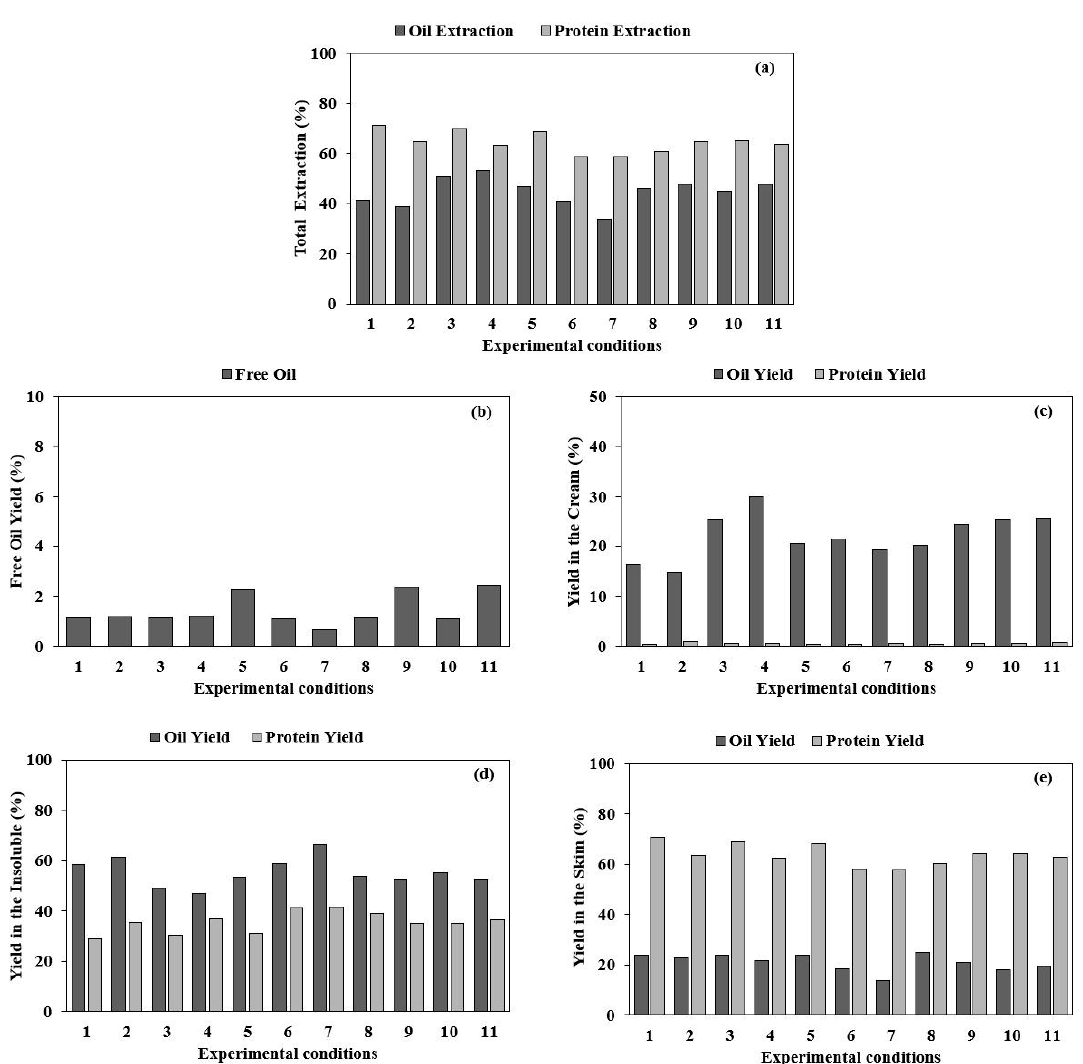
Figure 1. Effects of solids-to-liquid ratio (SLR) and reaction time on extraction yields and distribution of oil and protein among the fractions generated by the AEP: ( a ) Total oil and protein extraction yields (%); ( b ) free oil yield (%); ( c ) oil and protein yield in the cream (%); ( d ) oil and protein yield in the insoluble (%); ( e ) oil and protein yield in the skim (%). Experimental conditions: 1 (1:12 SLR, 0.75 h); 2 (1:8 SLR, 0.75 h); 3 (1:12 SLR, 3.0 h); 4 (1:8 SLR, 3.0 h); 5 (1:12.82 SLR, 1.88 h); 6 (1:7.18 SLR, 1.88 h); 7 (1:10 SLR, 0.29 h); 8 (1:10 SLR, 3.46 h); 9, 10, and 11 (1:10 SLR, 1.88 h) (central points).